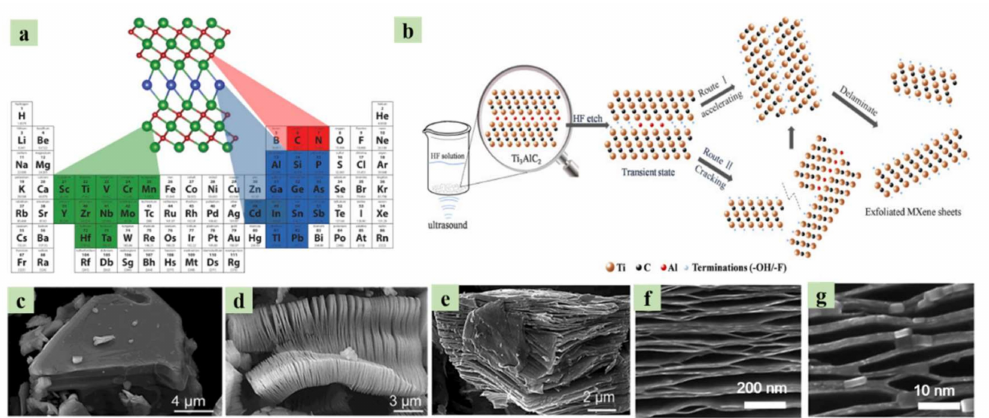
Figure 8. ( a ) M n + 1 AX n -producing elements from the MAX phase [114]. Copyright 2019 Elsevier. ( b ) Schematic diagram of the removal of A from MAX (exfoliation) and the conversion to MXenes